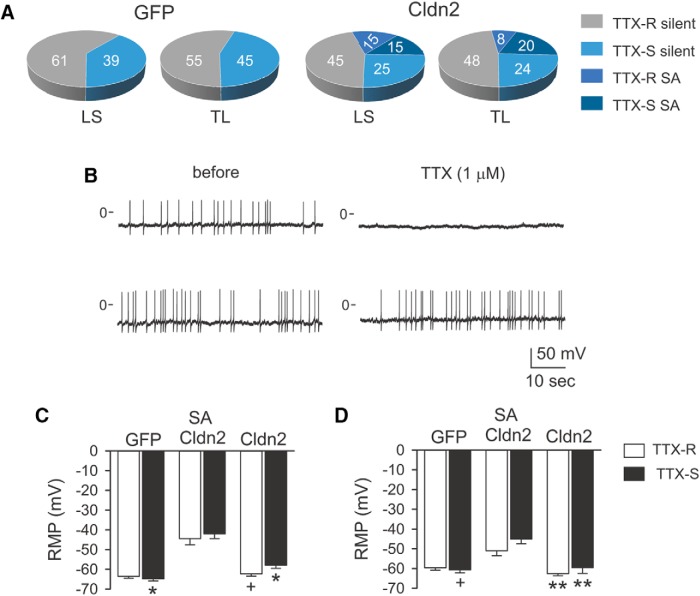
Overexpression of Cldn2 in the urothelium induces spontaneous activity in both LS and TL bladder sensory neurons. LS (L6-S2) and TL (T13-L2) DRGs were harvested from rats 9–13 d after injection of DiI in the bladder wall. The day before DRG collection, rats were transduced with AdGFP or AdCldn2. DRG neurons were isolated and cultured as indicated in Materials and Methods. Action potential activity in acutely isolated bladder sensory neurons was examined with the perforated patch-clamp technique. Sensory neurons were classified on the basis of their origin (LS or TL) and sensitivity of the action potential to 1 μM TTX (TTX-S or TTX-R). A, Proportion of silent and spontaneously active (SA) LS and TL neurons from rats transduced with AdGFP or AdCldn2. Neither LS nor TL bladder DRG neurons were spontaneously active in rats transduced with GFP (0/112). Approximately 30% (LS, 20/67 and TL, 15/54) of the neurons harvested from rats transduced with AdCldn2 showed spontaneous activity. Of the bladder neurons with spontaneous activity harvested from rats transduced with AdCldn2, 15% (10/67) of the LS sensory neurons exhibited TTX-S action potentials, while 20% (11/54) of the TL sensory neurons exhibited TTX-S action potentials. Data were collected from 12 rats transduced with AdGFP and 12 rats transduced with AdCldn2. B, Representative voltage tracings from bladder sensory neurons harvested from rats transduced with AdCldn2 with spontaneous TTX-S (upper panel) or TTX-R (lower panel) action potentials. C, Resting membrane potential of LS bladder sensory neurons. Statistically significant differences between neurons with spontaneous action potentials and their TTX-S or TTX-R silent counterparts are indicated as *p < 0.05 and +p < 0.001 (n = 10–36, Kruskal-Wallis test followed Dunn's multiple comparisons test). D, Resting membrane potential of TL bladder sensory neurons. Statistically significant differences between neurons with spontaneous action potentials and their TTX-S or TTX-R silent counterparts are indicated as **p < 0.01 and +p < 0.001 (n = 4–29, Kruskal-Wallis test followed Dunn's multiple comparisons test).